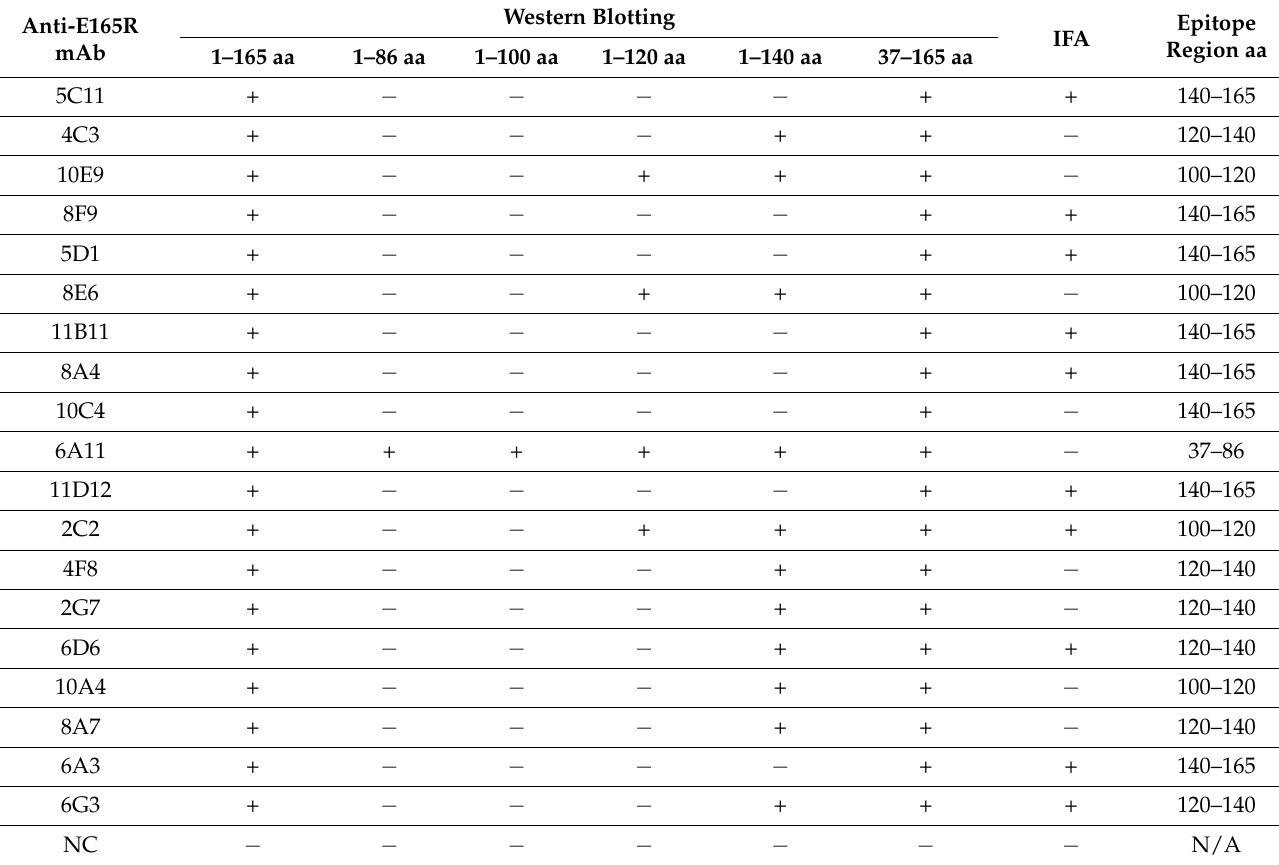
Table 1. Reactivity of anti-E165R mAbs generated in this